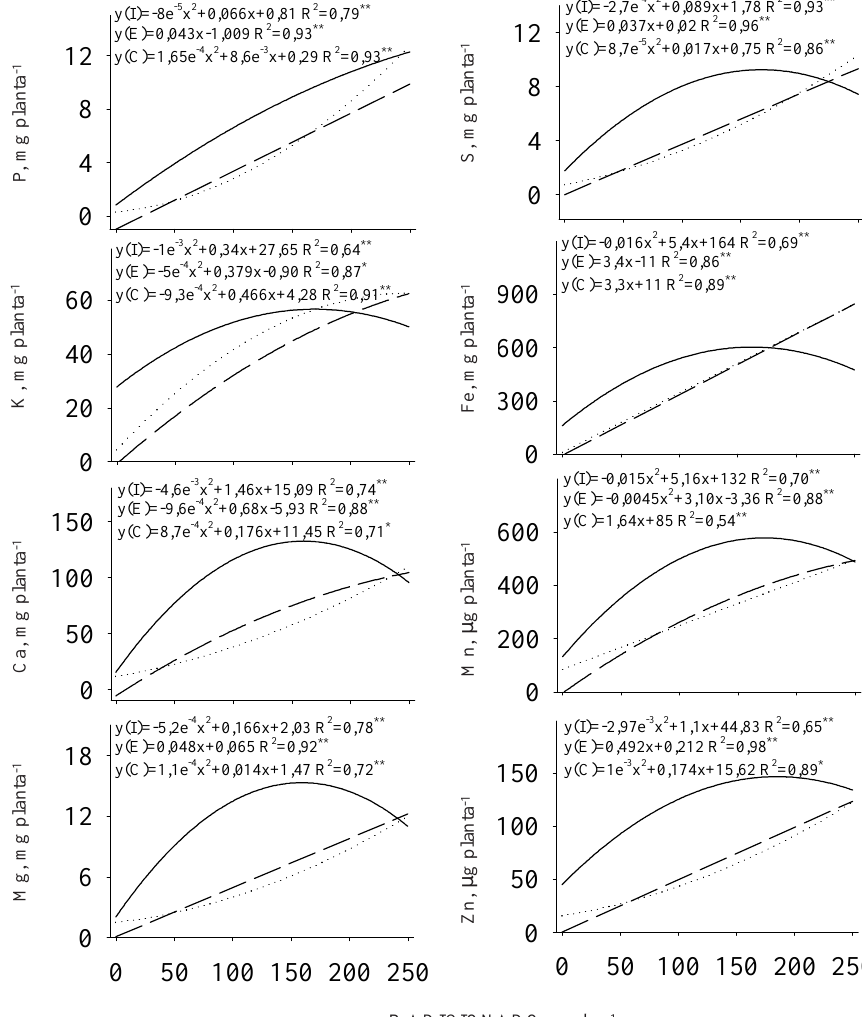
Figura 2. Nutrientes acumulados na parte aérea de limoeiro-cravo, considerando as doses de P. * e ** significativos a 5 e 1%,